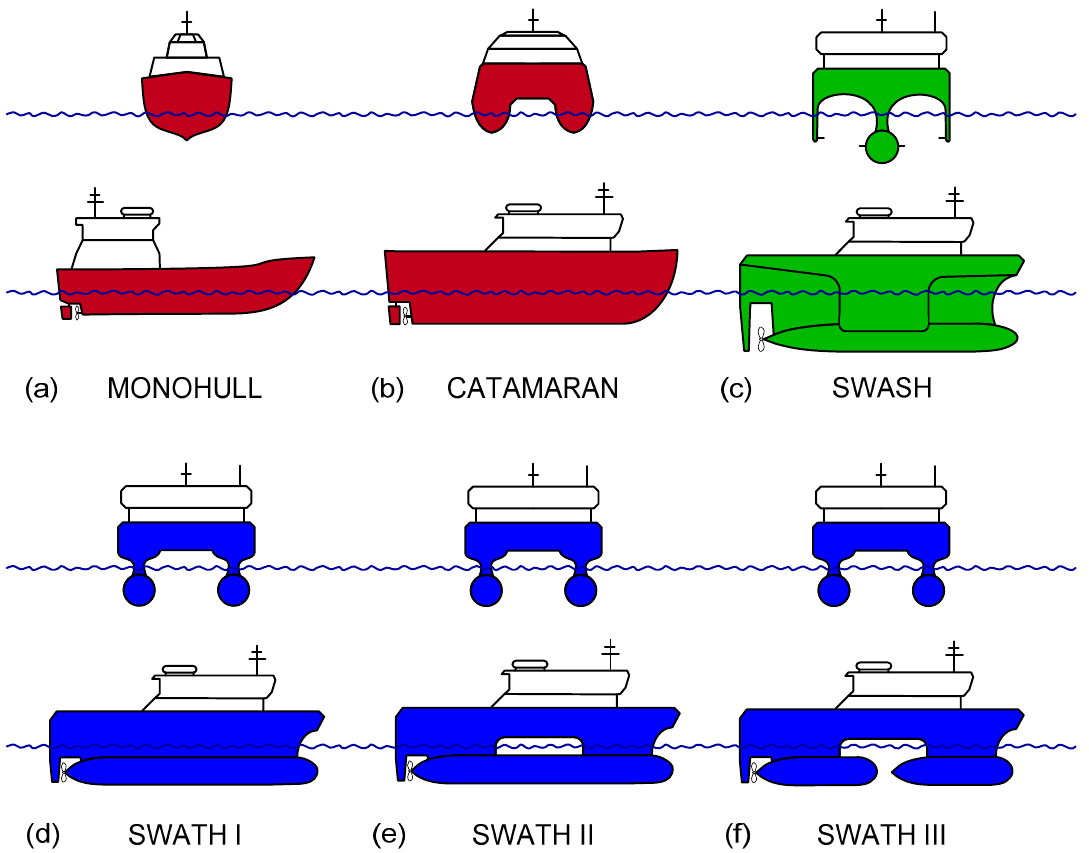
Figure 1. Comparison of hull shapes of various vessel types: ( a ) MONOHULL, ( b ) CATAMARAN, ( c ) SWASH, ( d ) SWATH I, ( e ) SWATH II, ( f ) SWATH III.